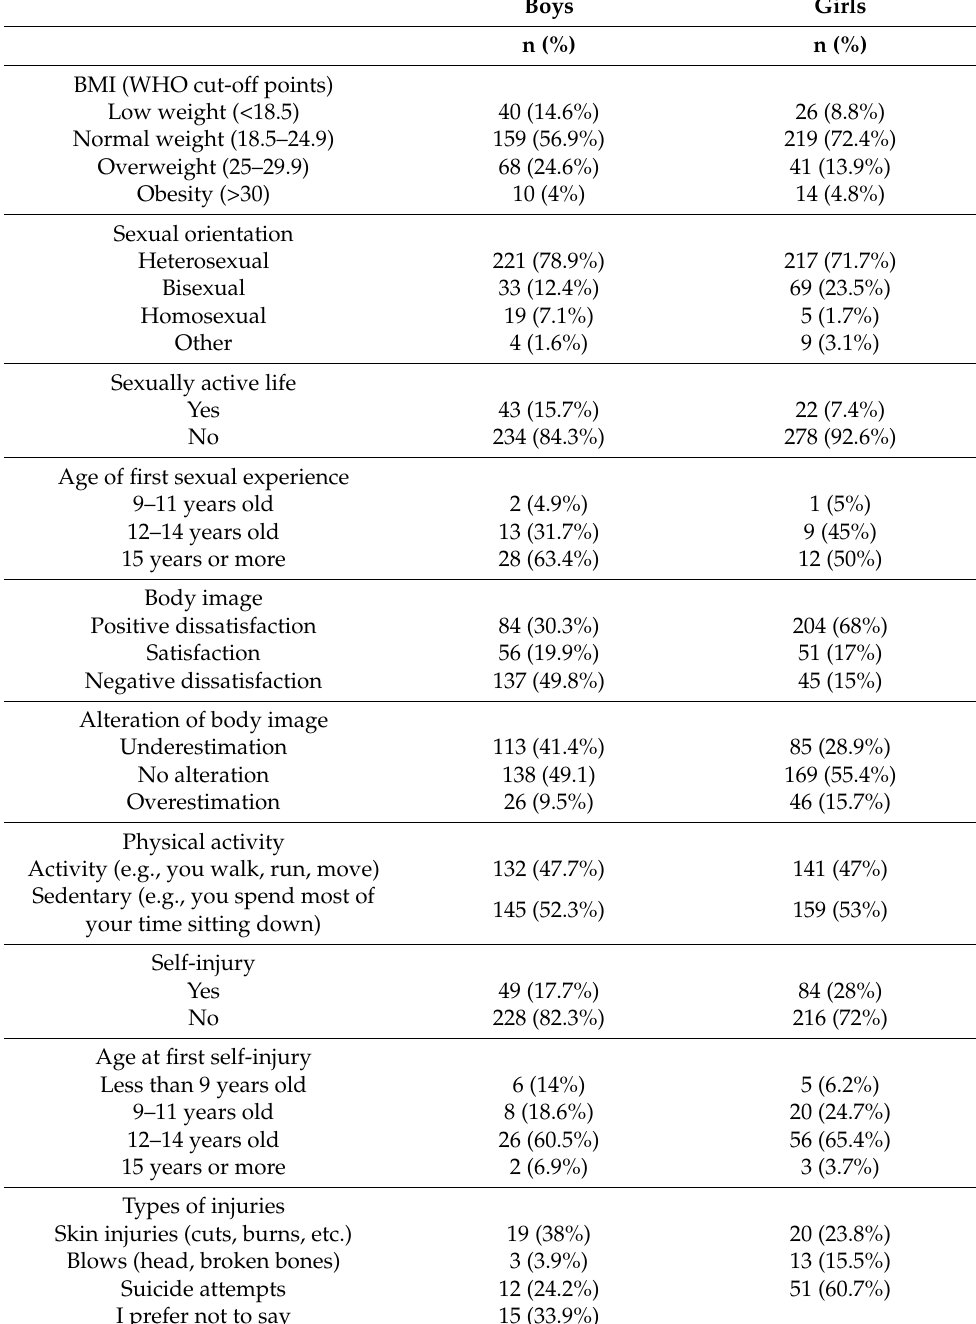
Table 1. Sociodemographic, body image, physical activity, and self-injury variables. Boys